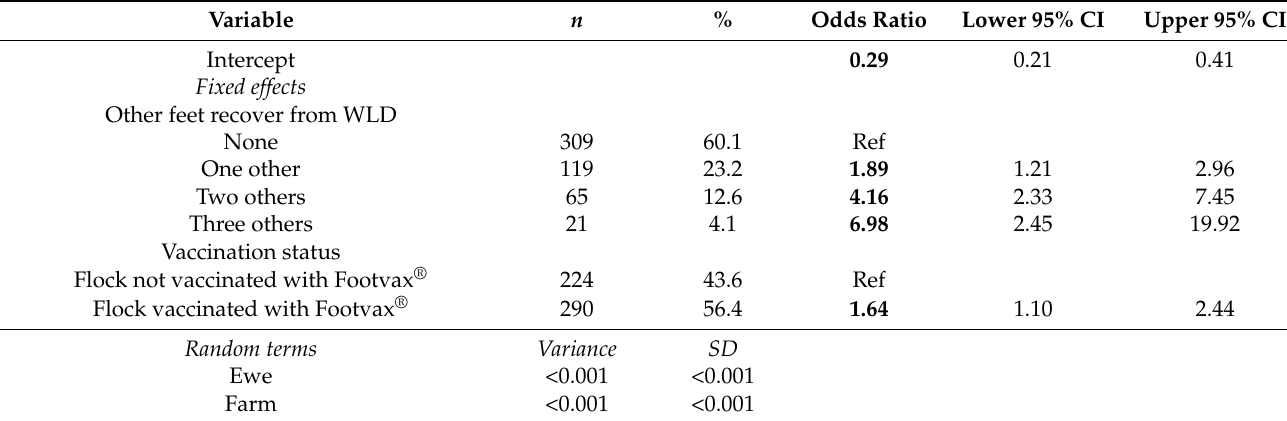
Table 12. Final multivariable model of the associations with the recovery from WLD at foot-level for 514 observations of 256 ewes during transition period 1 (September 2019–January